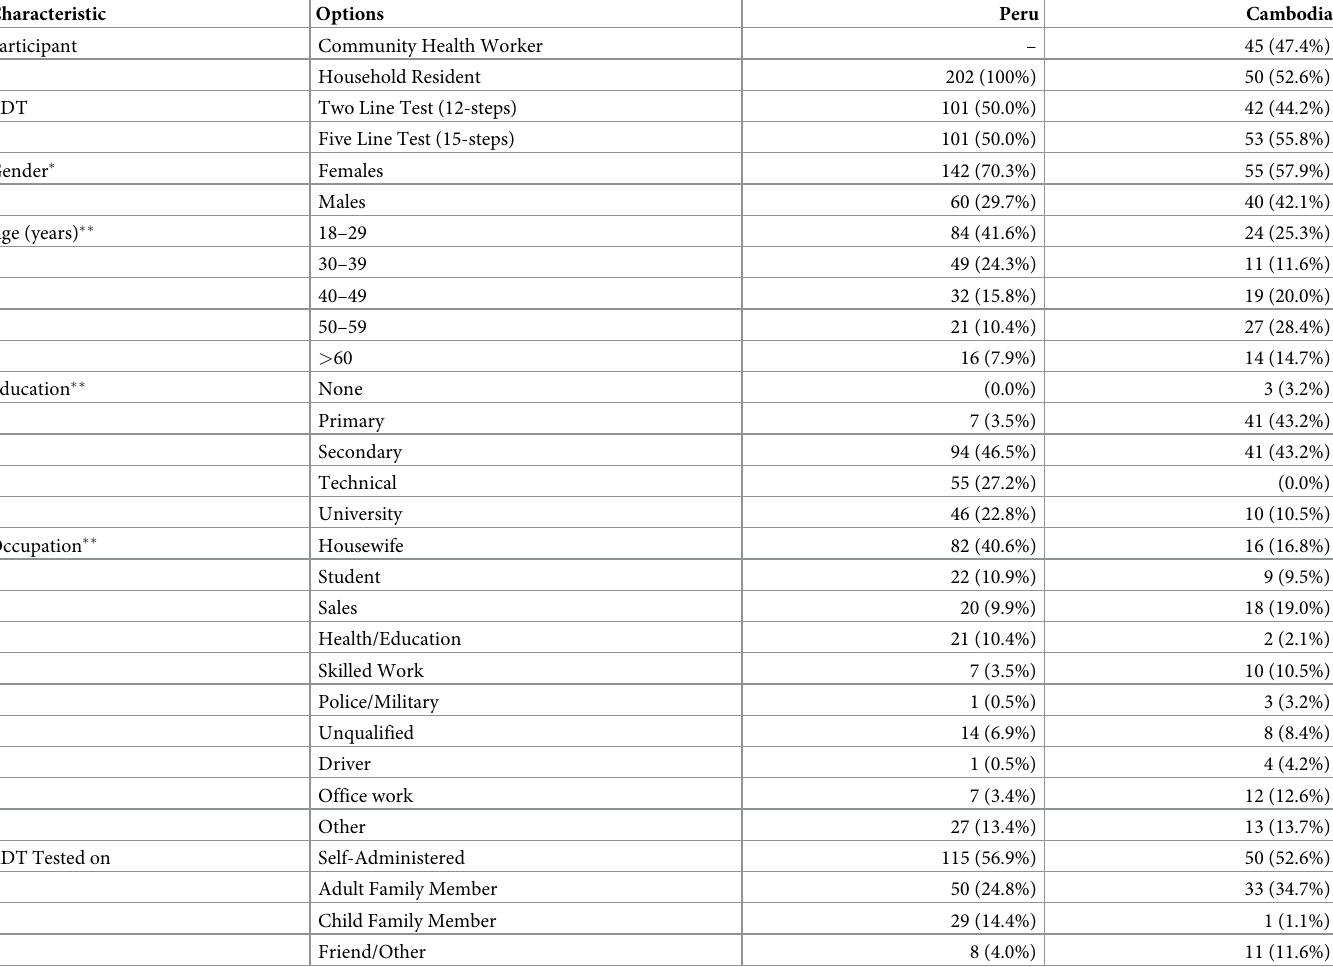
Table 1. Summary of study population of device application by community members (excluding the 8 Community Health Workers in Cambodia that participated in a separate experiment described below).